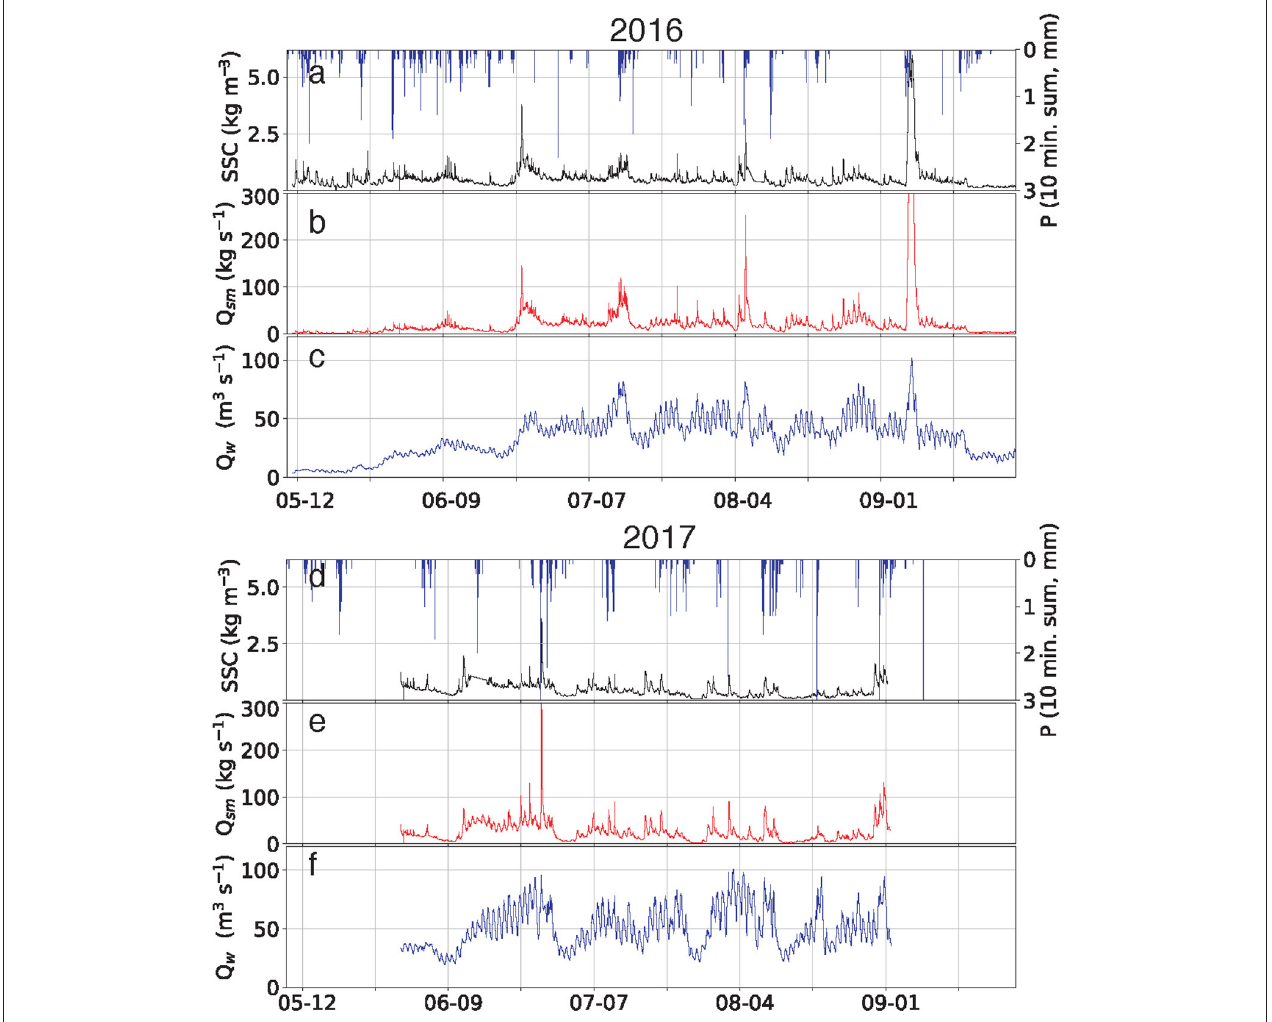
FIGURE 6 | Time series of the Aletschgletscher catchment data over the 2016 and 2017 seasons. (a,d) Suspended sediment concentration (SSC); blue bars represent precipitation (P). (b,e) Sediment discharge (Q s ). (c,f) water discharge (Q w